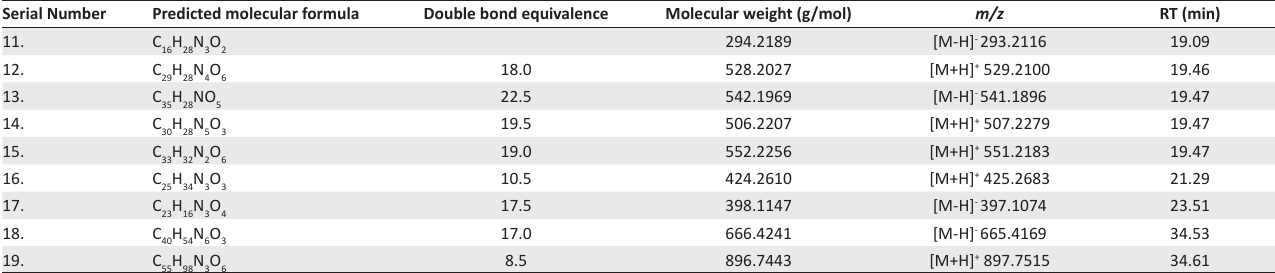
TABLE 2: Unidentified compounds in Dryopteris filix-mas . Double bond equivalence indicates number of rings and double bonds in the structure, where 1 ring = 1 double bond